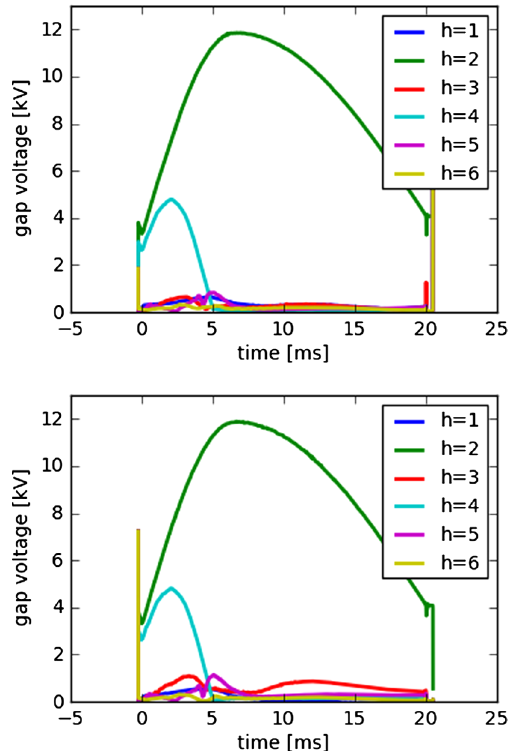
FIG. 4. The harmonic components of the gap voltage of (top) cavity #1 and (bottom) cavity #12 with feedforward for the odd harmonics with the modified phase patterns.